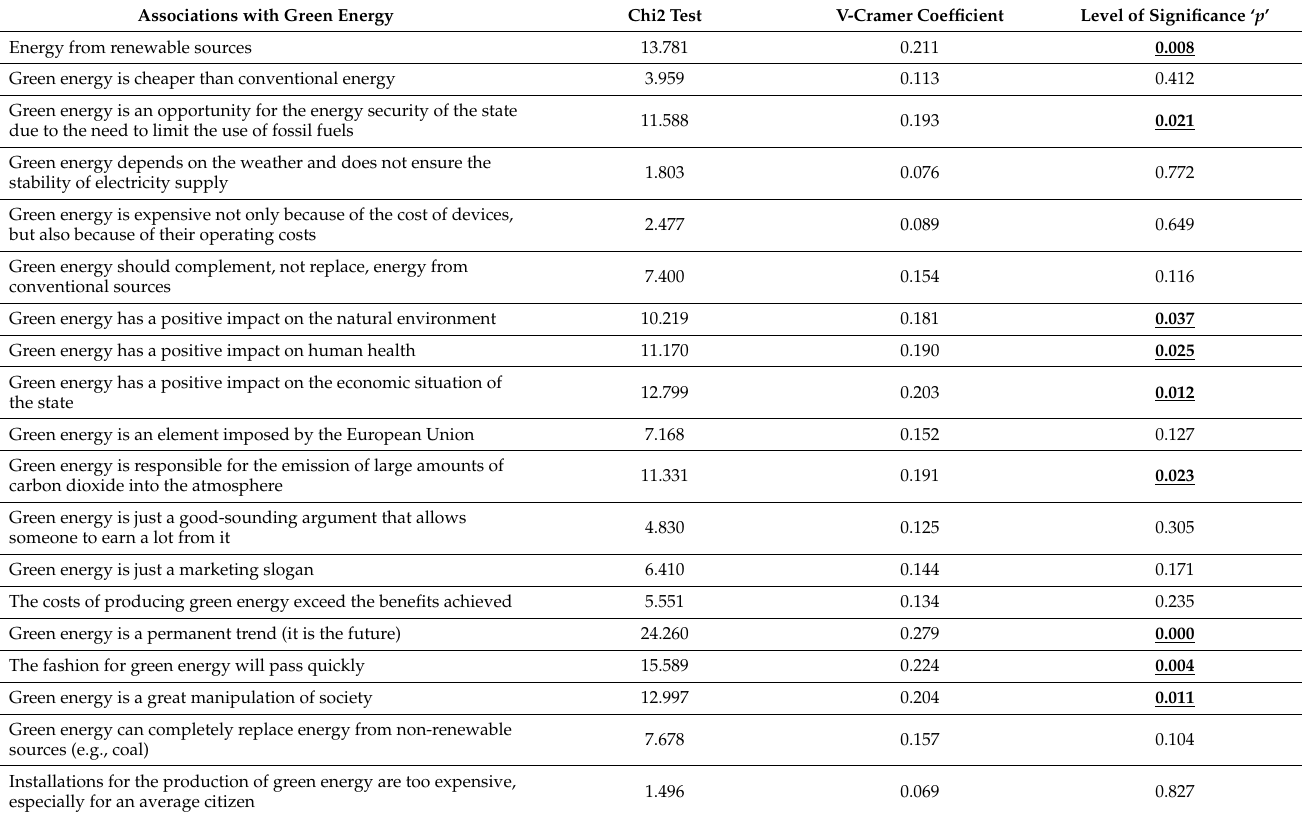
Table 5. Respondents’ associations with green energy and the importance ascribed to the sources of the energy used.